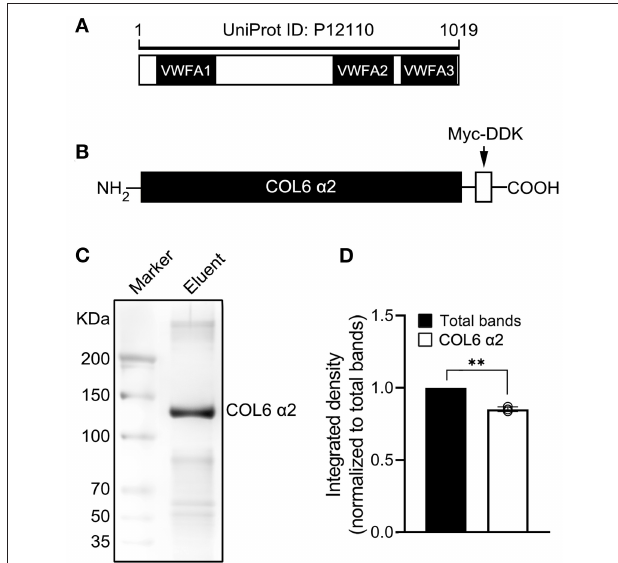
FIGURE 2 | Schematic diagram of the COL6 α 2 chain domains and the recombinant COL6 α 2 protein used in this study. (A) The scale of amino acid is shown on the top. The COL6 α 2 full-length chain (UniProt ID: P12110) is mainly composed of VWFA1, VWFA2, and VWFA3 domains. (B) Schematic diagram of the recombinant COL6 α 2 full-length chain. A Myc-DDK tag was added at the C-terminal of the COL6 α 2 chain. (C) After purification, the purity of the Myc-DDK-tagged COL6 α 2 was analyzed via SDS-PAGE and visualized by silver staining. (D) The statistical analysis based on optical density of the protein bands determined that the purity of the recombinant COL6 α 2 was 85.24 ± 1.56% ( n = 3 independent biological experiments, ** p = 0.0043, ratio paired t -test).